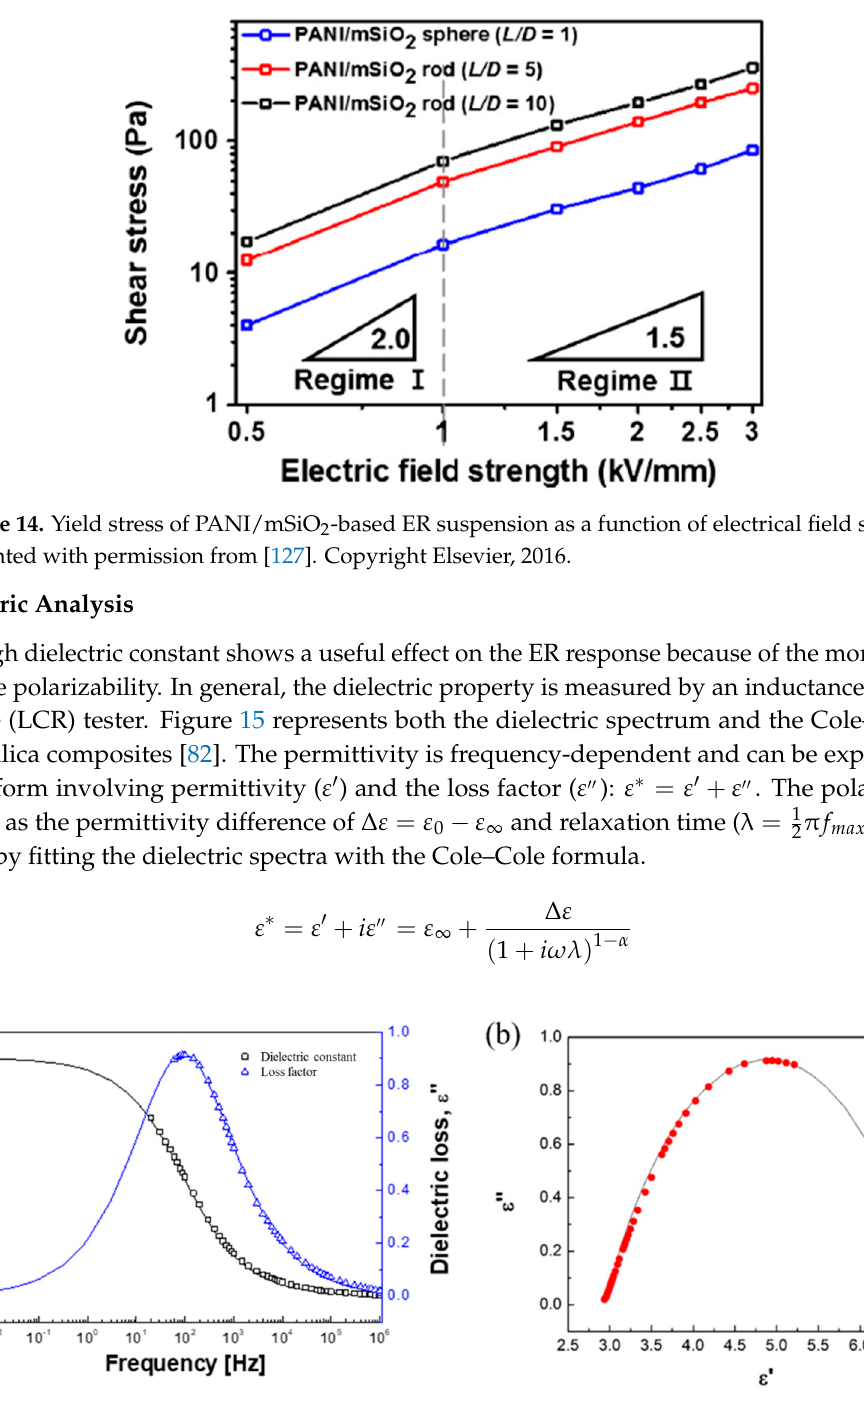
Figure 13. Yield stress vs. electrical field strength for highly substituted potato starch phosphate (HPSP)-based ER suspension with different molar ratios, reprinted with permission from [124]. Copyright American Chemical Society, 2005.